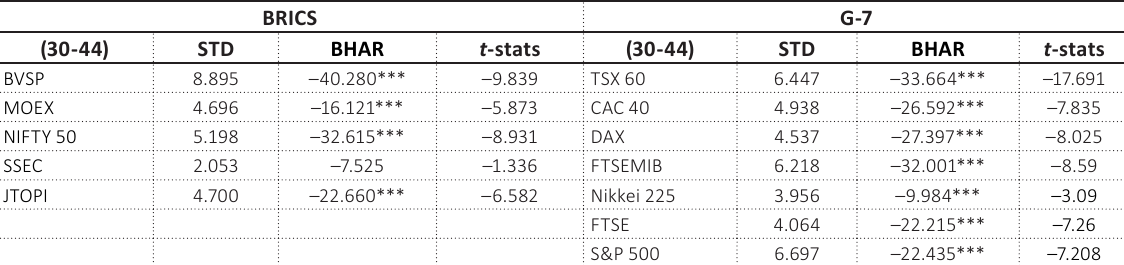
Table 5. BHAR in the event window (30-44) for G-7 and